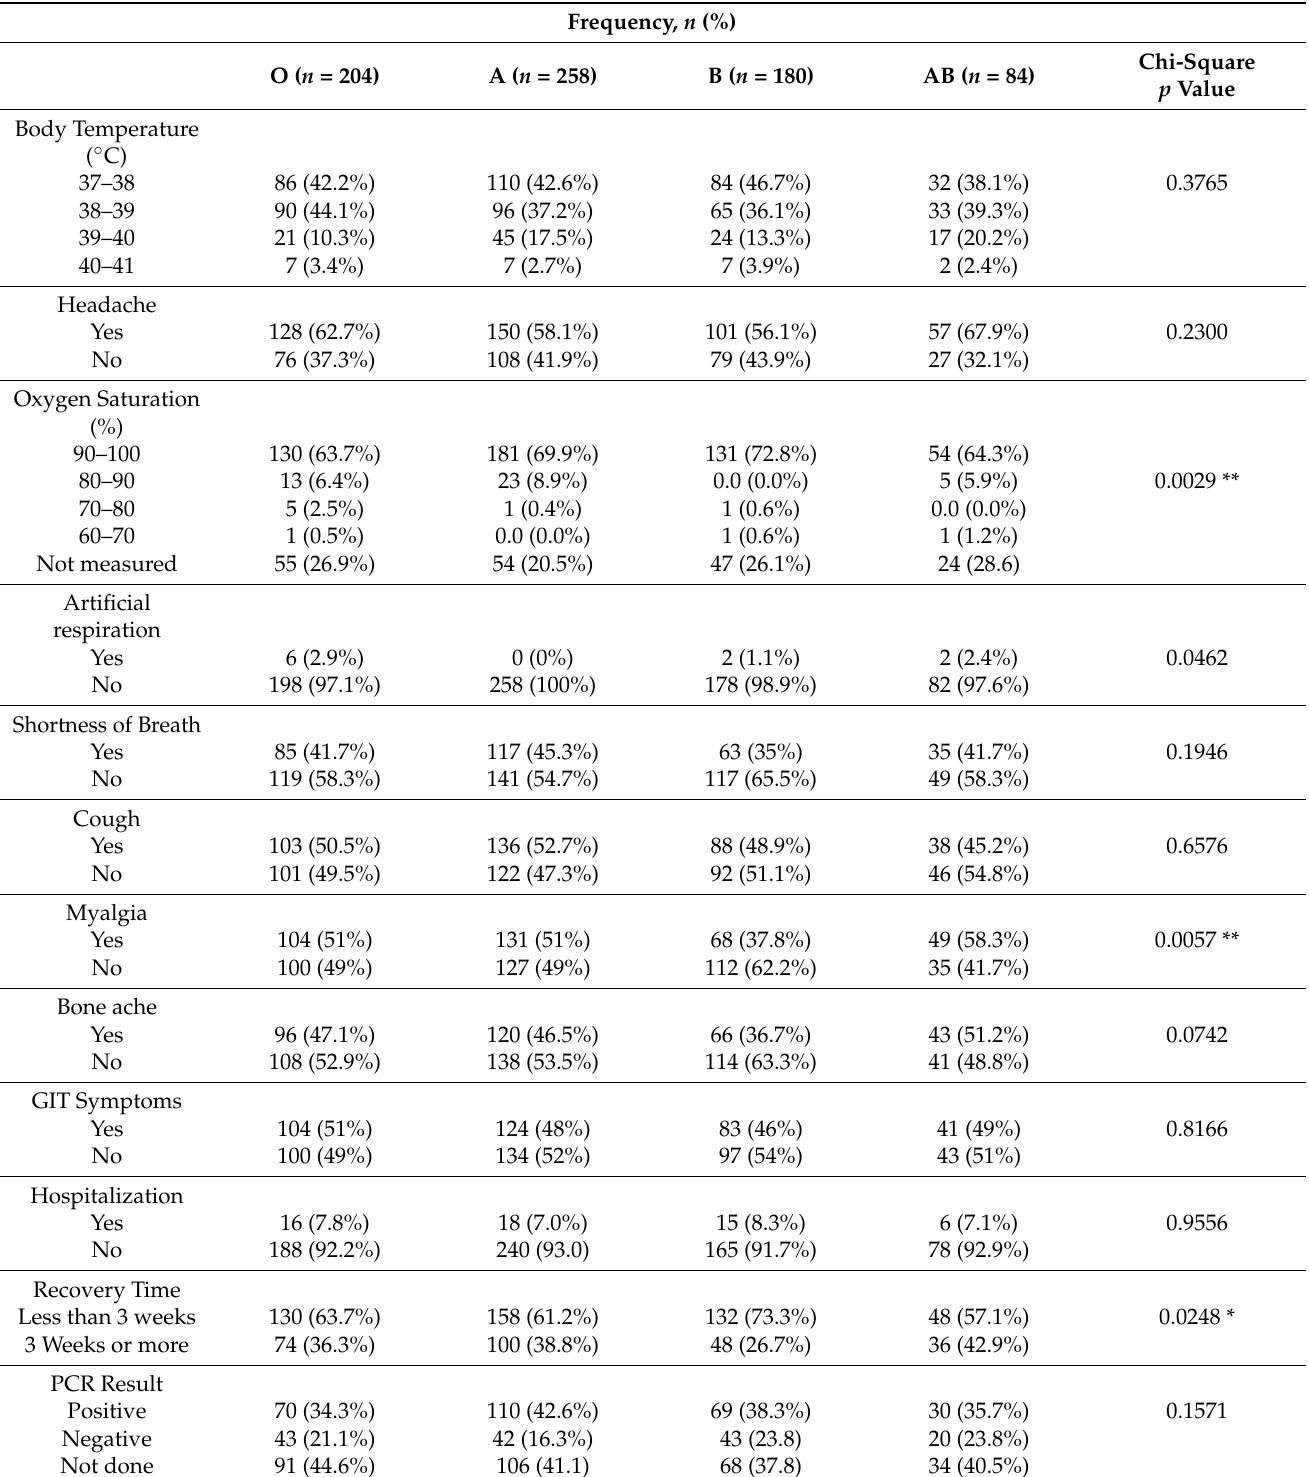
Table 2. Correlation of different COVID-19 symptoms: need for hospitalization, recovery time, diagnostic smear (PCR) results, and ABO blood grouping